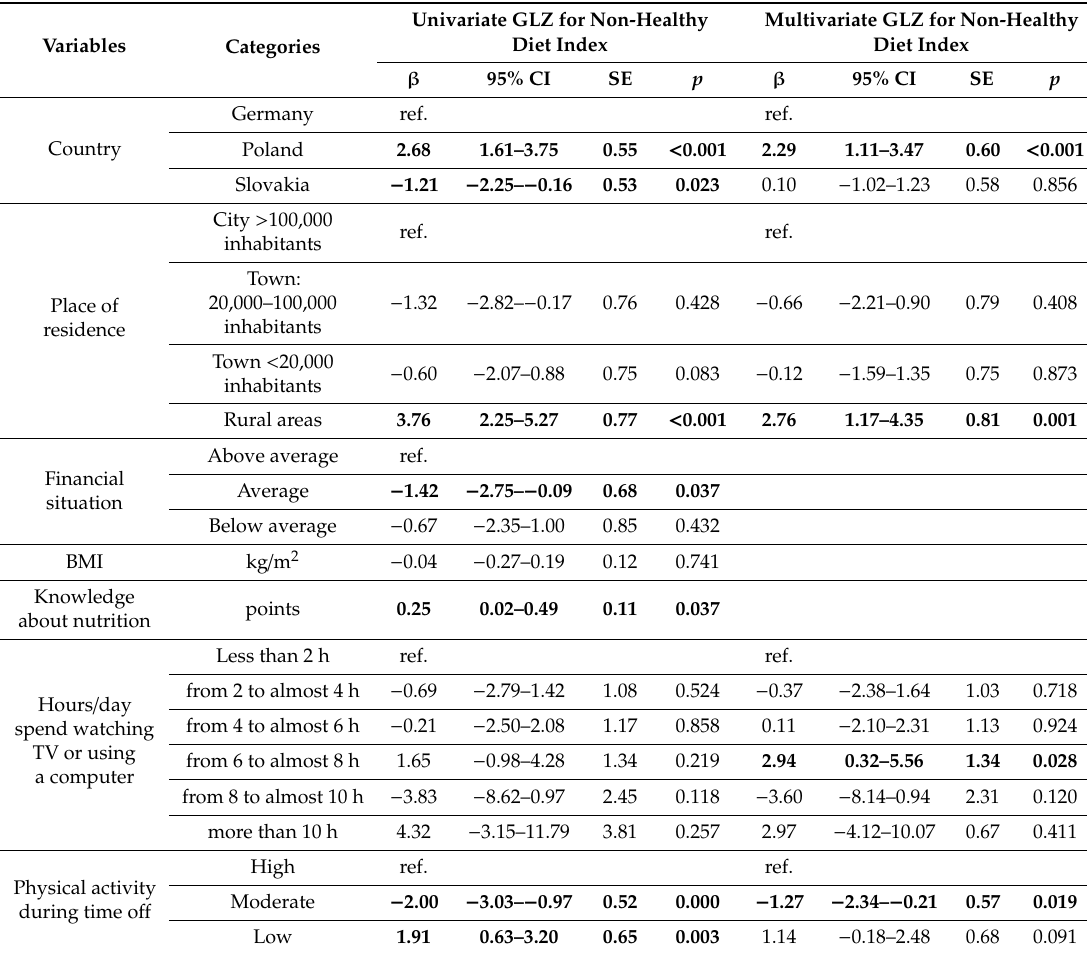
Table 6. Univariate and multivariate generalized linear regression analysis for the Non-Healthy Diet